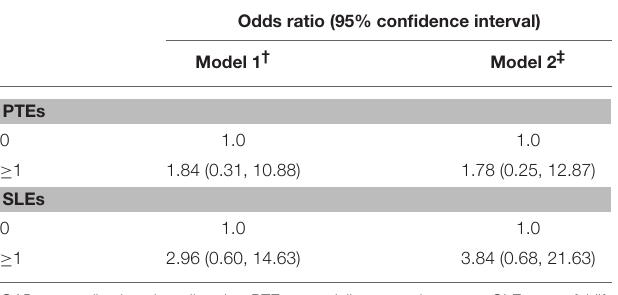
TABLE 1 | Sociodemographic characteristics of a subset of women in the TABLE 2 | Associations between maternal PTEs and SLEs during Detroit Neighborhood Health Study and their children. pregnancy and offspring lifetime history of GAD among a subset of women in the Detroit Neighborhood Health Study and their Offspring lifetime history of GAD a N = 69 No P - Yes ( N = 58) ( N = 7) value b